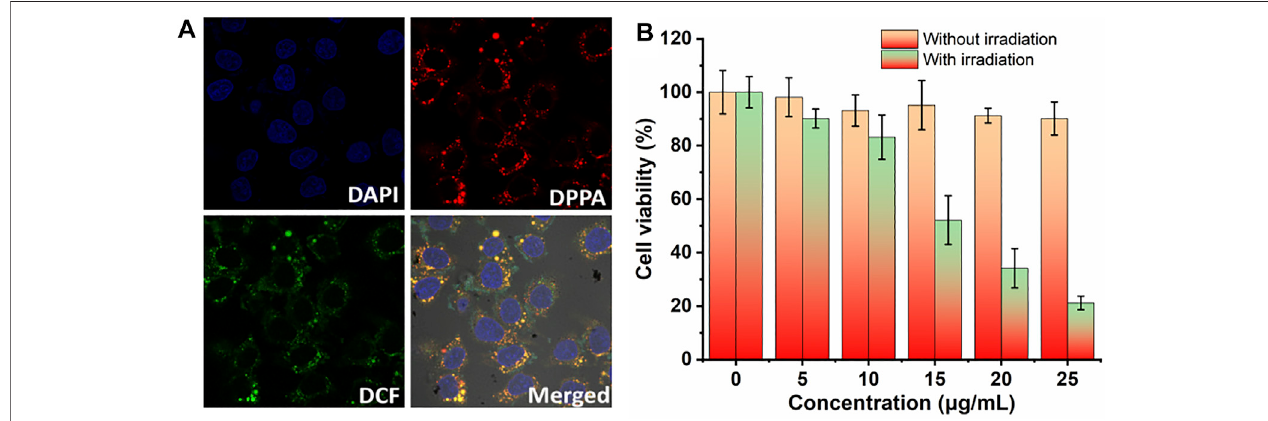
FIGURE3|(A) Invitro cellularuptakeofDPPANPsinA498cellsandROSgenerationinthepresenceofDCF-DAasaprobe(660 nm,100 W/cm 2 ). (B) Cellviability of A498 cells in the presence of DPPA NPs at different concentrations (0, 5, 10, 15, 20, and 25 μ g/ml) (660 nm, 100 W/cm 2 , 8